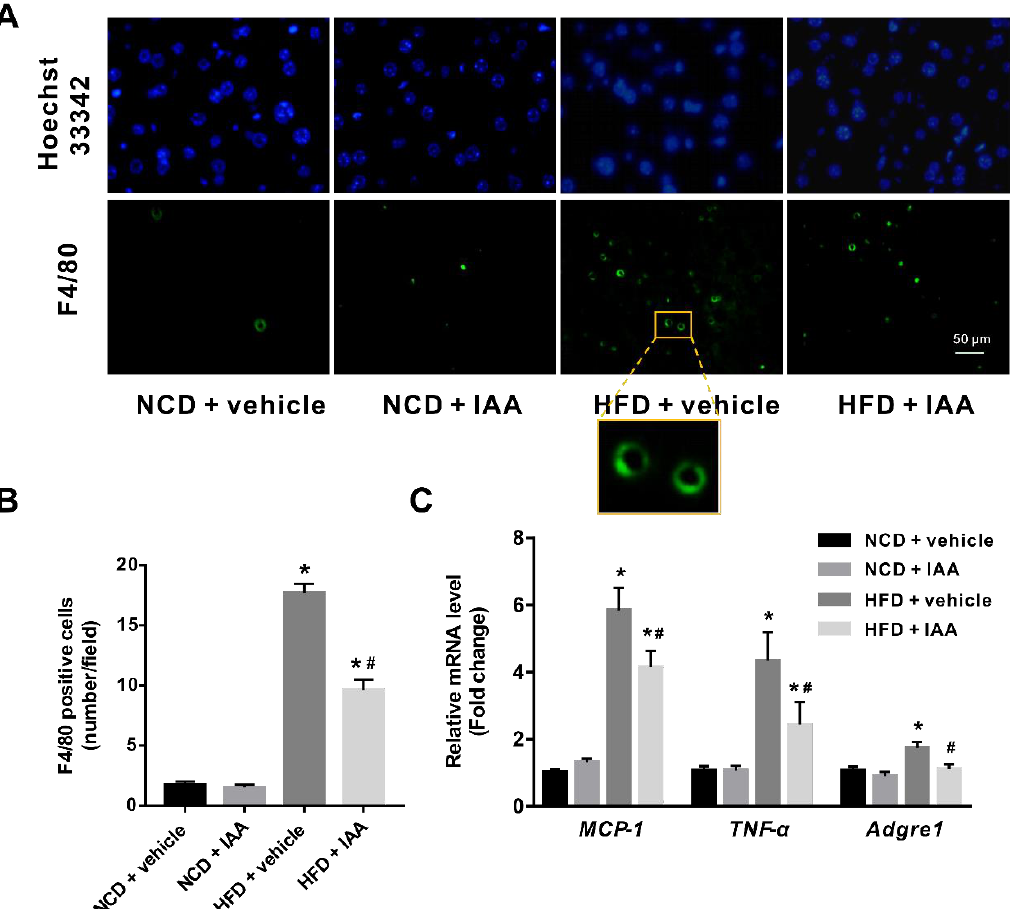
Figure 6. Inflammatory stress in liver of mice induced by high-fat diet (HFD) was ameliorated by indole-3-acetic acid (IAA) treatment. ( A ) Immunofluorescence analysis for F4 / 80 antigen in liver tissue section. Scale bar represents 50 µ m. ( B ) Count of F4 / 80 positive cells per field (at least six field per mice) ( C ) Relative mRNA abundance of MCP-1 , TNF- α , and Adgre1 . Values are presented as the mean ± standard error of the mean. n = 6. * p < 0.05 vs. NCD + vehicle; # p < 0.05 vs. HFD + vehicle.